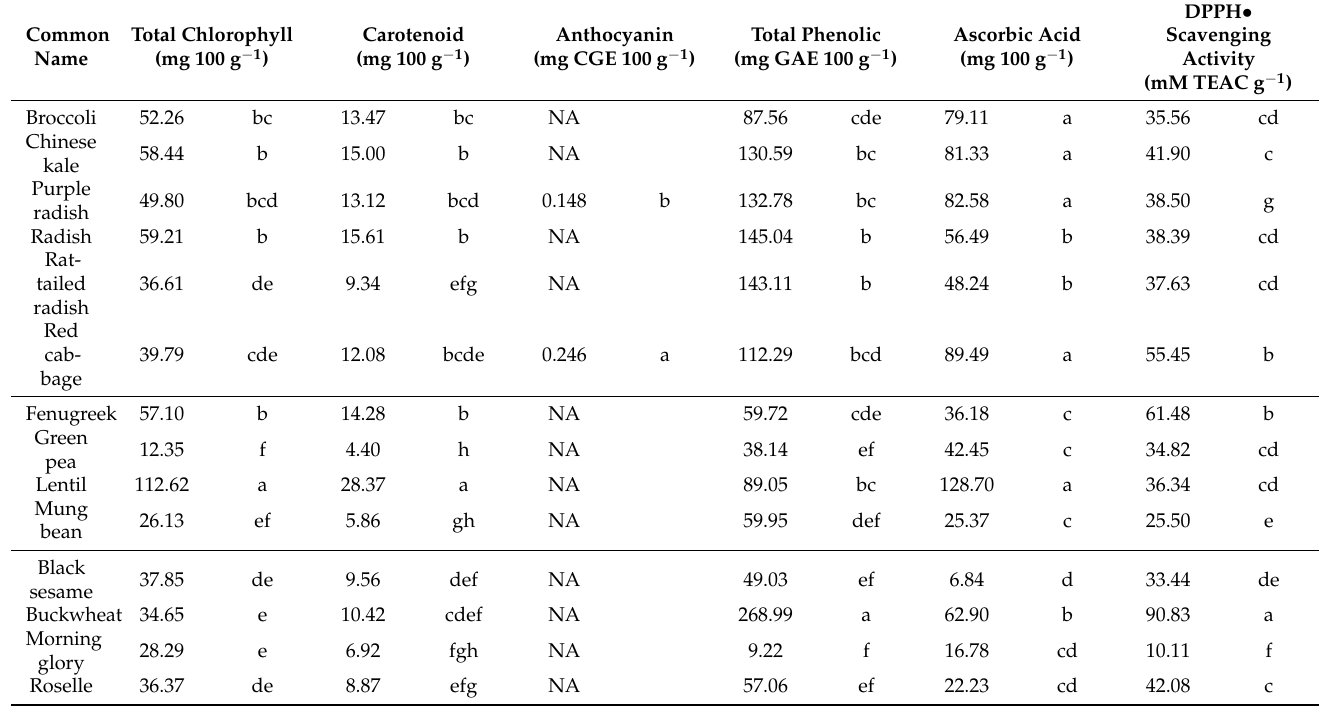
Table 4. Total chlorophyll, carotenoid, anthocyanin, phenolic, and ascorbic acid contents and total antioxidant activity of the microgreens grown under controlled